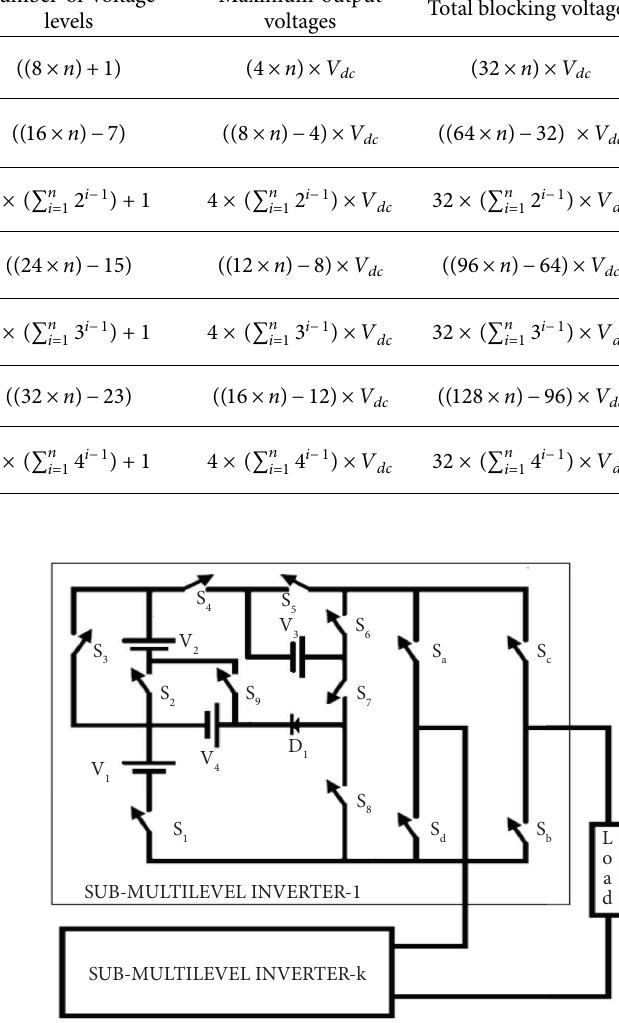
Figure 5: Submultilevel inverter